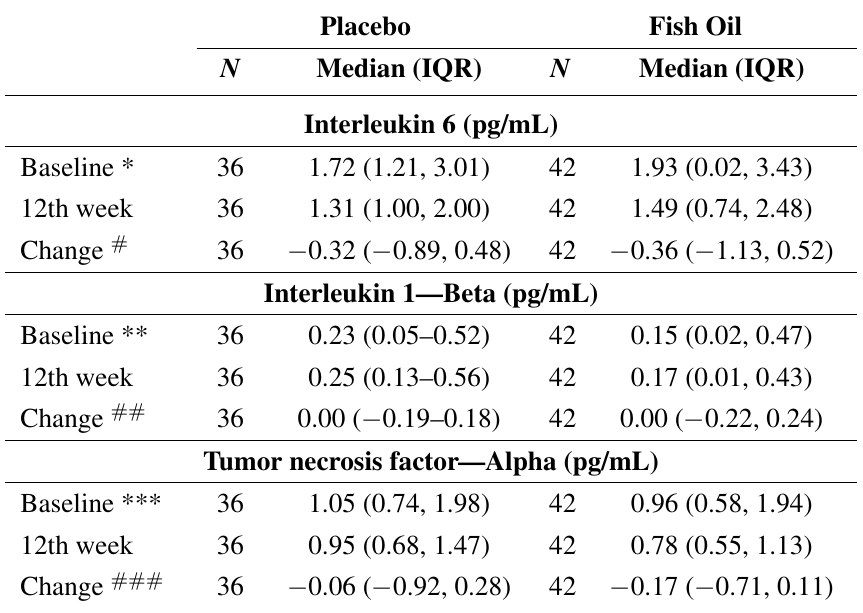
Table 3. Primary endpoints—Interleukin 6, Interleukin1-beta, Tumor necrosis factor-alpha.